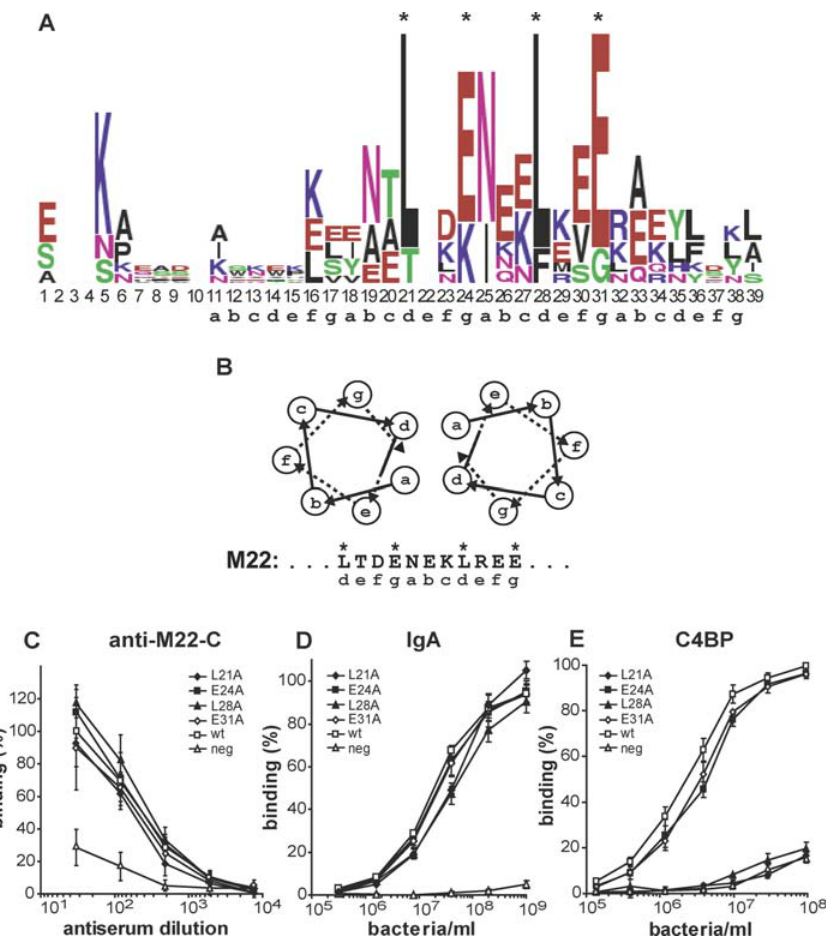
Figure 5. Sequence Analysis of C4BP-Binding HVRs and Site-Specific Mutagenesis in M22 (A) Sequence logo of C4BP-binding HVRs. The logo was generated from the seven C4BP-binding HVRs aligned in Figure 1B, using WebLogo (http:// weblogo.berkeley.edu). Only regions in the HVRs corresponding to the shortest known C4BP-binding region in M22 (residues 1–39) were used to create the logo. These regions are demarcated by the vertical hatched lines in Figure 1B. In the logo, each column in the alignment is represented by a stack of letters, with the height of each letter proportional to the observed frequency of the corresponding residue at that position, while the overall height of each stack is proportional to the sequence conservation at that position [63]. The sequence of the M4.1 HVR was included in the generation of the logo, although it is virtually identical to M4, because the single residue difference between these two HVRs was important for the conclusion that the different HVRs completely lack residue identities (see text). The numbering below the logo refers to residue numbers in the M22 protein and putative coiled-coil heptads (a–g) in M22 are indicated. Asterisks show the position of four M22 residues (L21, E24, L28, and E31) analyzed by site-specific mutagenesis. (B) Helical wheel representation of a dimeric coiled-coil [42]. The sequence of the L21–E31 region of M22 is included, with asterisks above residues L21, E24, L28, and E31, which were analyzed by site-specific mutagenesis and are located within the predicted coiled-coil region. The positions of residues within putative coiled-coil heptads (a–g) are indicated. (C–E) The four mutant M22 proteins indicated, constructed by site-specific mutagenesis, and the wild-type (wt) M22 protein, were expressed in S. pyogenes, and the strains were analyzed for surface expression of the proteins and ability to bind C4BP. The genes encoding the proteins were present on plasmid pLZ12Spec, carried by an M-negative strain. This M-negative strain also served as negative control. (C) and (D) show that the different proteins were expressed normally on the bacterial surface (see text). (E) shows that mutants L21A and L28A had completely lost C4BP-binding ability, while mutants E24A and E31A were unaffected. The results shown in (C–E) are based on three separate experiments with duplicate samples and are presented as means 6 SD. DOI: mutant M22 proteins were expressed in S. pyogenes. To analyze protein expressed by the positive control (Figure 5C), and whether the mutant proteins were expressed normally on the similar results were obtained in binding analysis with IgA bacterial surface, the strains were analyzed for reactivity with (Figure 5D). Thus, the mutant M22 proteins were expressed normally on the streptococcal surface, making them suitable antibodies against the conserved C-repeat region in M22 and for analysis of the role of the mutated residues in binding of for ability to bind human IgA, which specifically binds to M22 C4BP (Figure 5E). [39]. The analysis with anti-C serum was performed with antibodies raised in the rat, because rabbit antibodies show The L21A and L28A mutants had completely lost ability to Fc-reactivity with M22 [39]. Analysis with this rat serum bind C4BP, a finding that may be explained by the key role showed that the mutant proteins were present on the that residues in heptad position d play as core residues in a streptococcal surface in the same amounts as the wild-type coiled-coil. In contrast, the E24A and E31A mutants were not